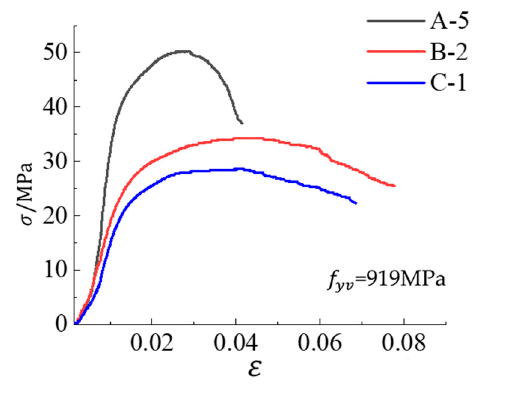
Figure 5. Influence of stirrup form. ( a ) Stress–strain curves of specimens with different stirrup forms when the stirrup strength is 919 MPa; ( b ) Stress–strain curves of specimens with different stirrup forms when the stirrup strength is 412 MPa. Figure 6 indicates the influence of stirrup strength on the stress–strain curve of the specimen. The peak stress and strain of specimen A-5 ( f yv = 919 MPa) are higher than those of specimen A-4 ( f yv = 412 MPa), and the declining phase of the stress–strain curve of the former specimen is more gentle. So, the strength and ductility of concrete specimens with high-strength stirrup constraints are better than those with ordinary-strength stirrup constraints. In addition, due to the casting problem, the concrete strength of specimen A-2 is relatively low, so the peak strength of its curve in Figure 6 is the lowest, but the descending section is the most gentle.